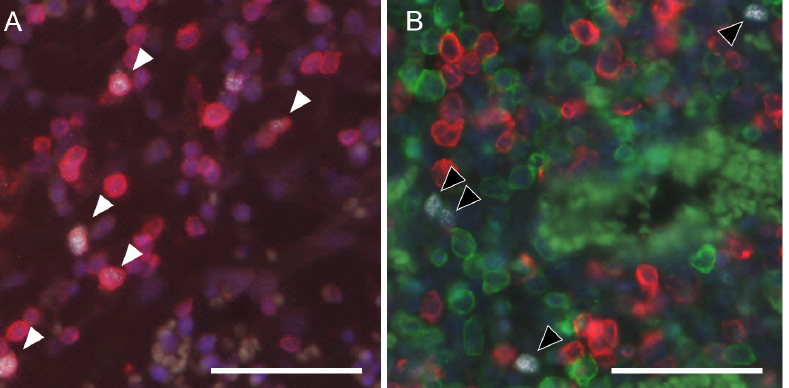
Figure 5. Immunofluorescence staining of fetal bovine bone marrow (A) and lymph node (B). Red: B lymphocyte marker CD79 a . Green: T lymphocyte marker CD3. White: TdT. Blue: DAPI. White arrows: TdT positive B cells. Black arrows: TdT positive T cells. Scale bar: 50 m m.